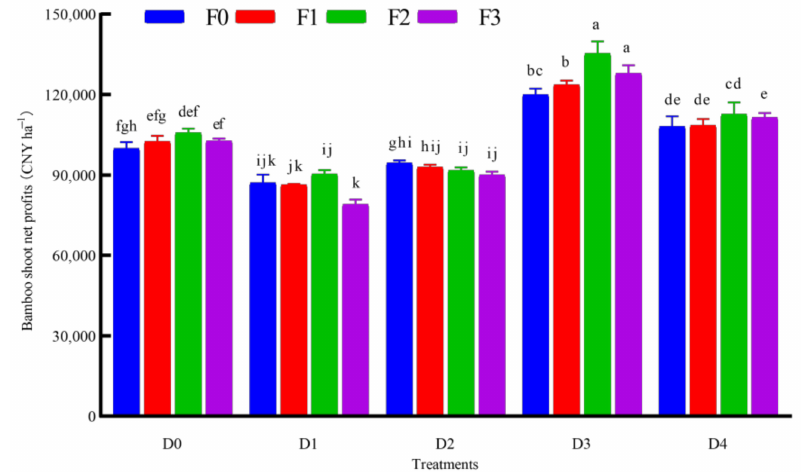
Figure 2. The bamboo-shoot net profit of C. pachystachys forests by treatments. Error bars indicate standard error ( n = 3). Different lowercase letters show significance at the 0.05 level according to Bonferroni’s test.